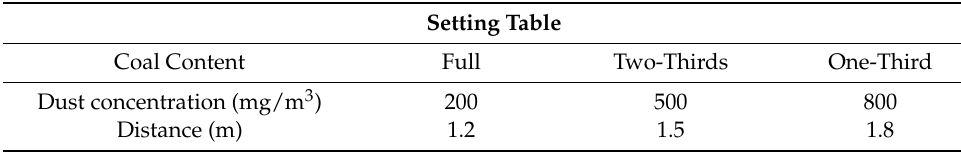
Table 2. Experimental factors setting table.